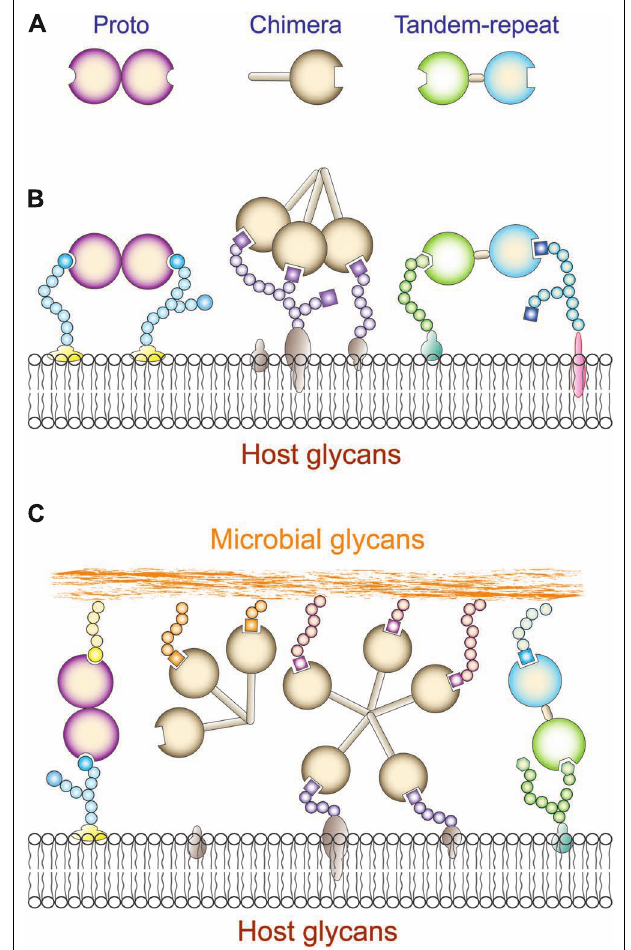
FIGURE 2 | Galectin recognition. (A) Schematic representation of galectin domain organization; (B) Schematic illustration of cis- interactions of proto, chimera, and tandem repeat galectins with host cell surface glycans. (C) Schematic illustration of trans- interactions of proto, chimera, and tandem repeat galectins with host cell surface and microbial glycans. Proto- and trandem repeat-type galectins can cross-link host and microbial glycans. Chimera galectins (galectin-3) can recognize microbial glycans but it is not clear that they can cross-link them to the host cell